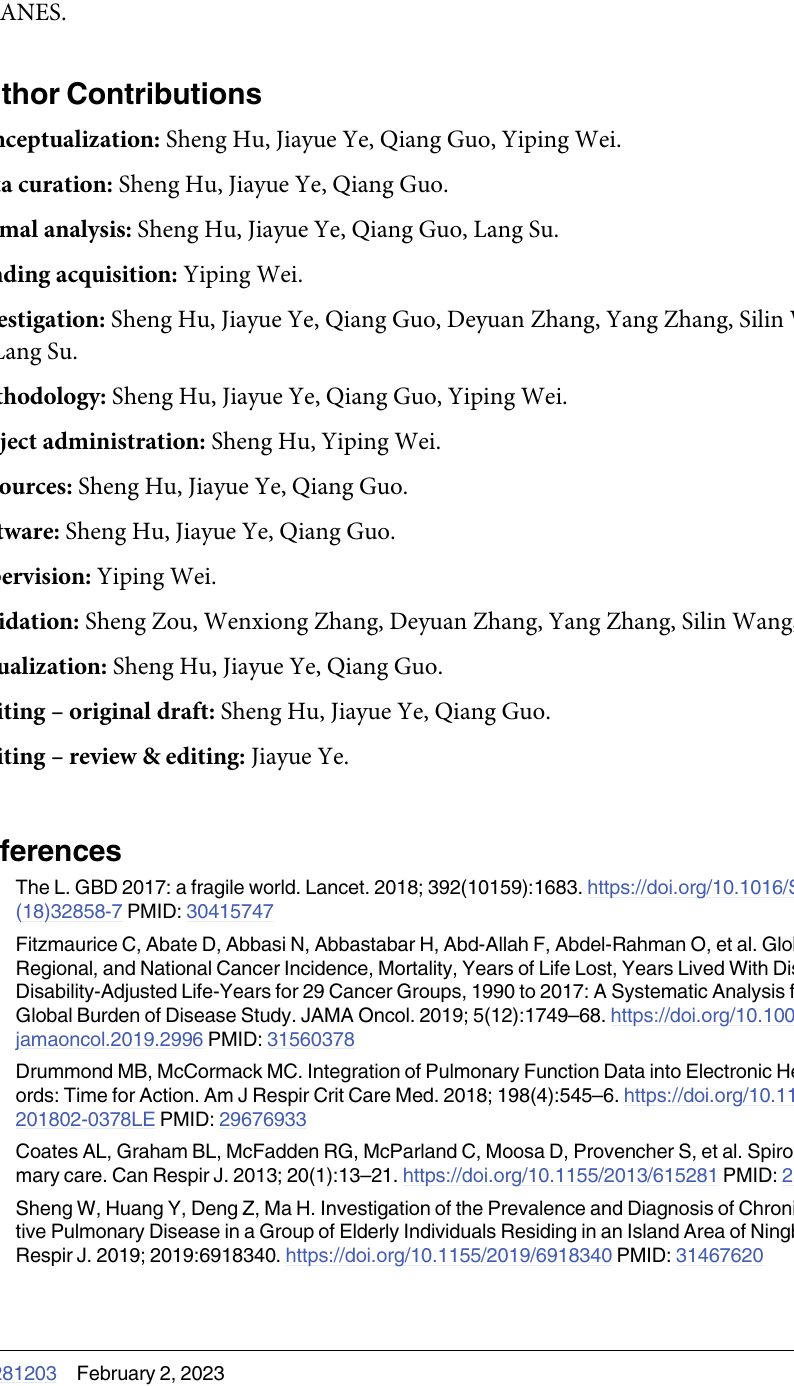
S7 Table. Analysis of threshold effect and saturation effect (Stratification by thoracic/ abdominal